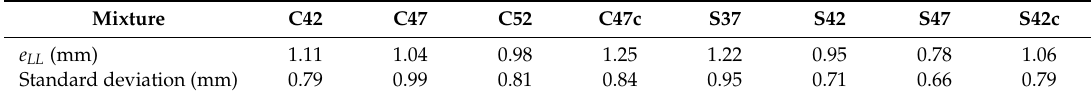
Table 5. Average experimentally determined thickness of the lubricating